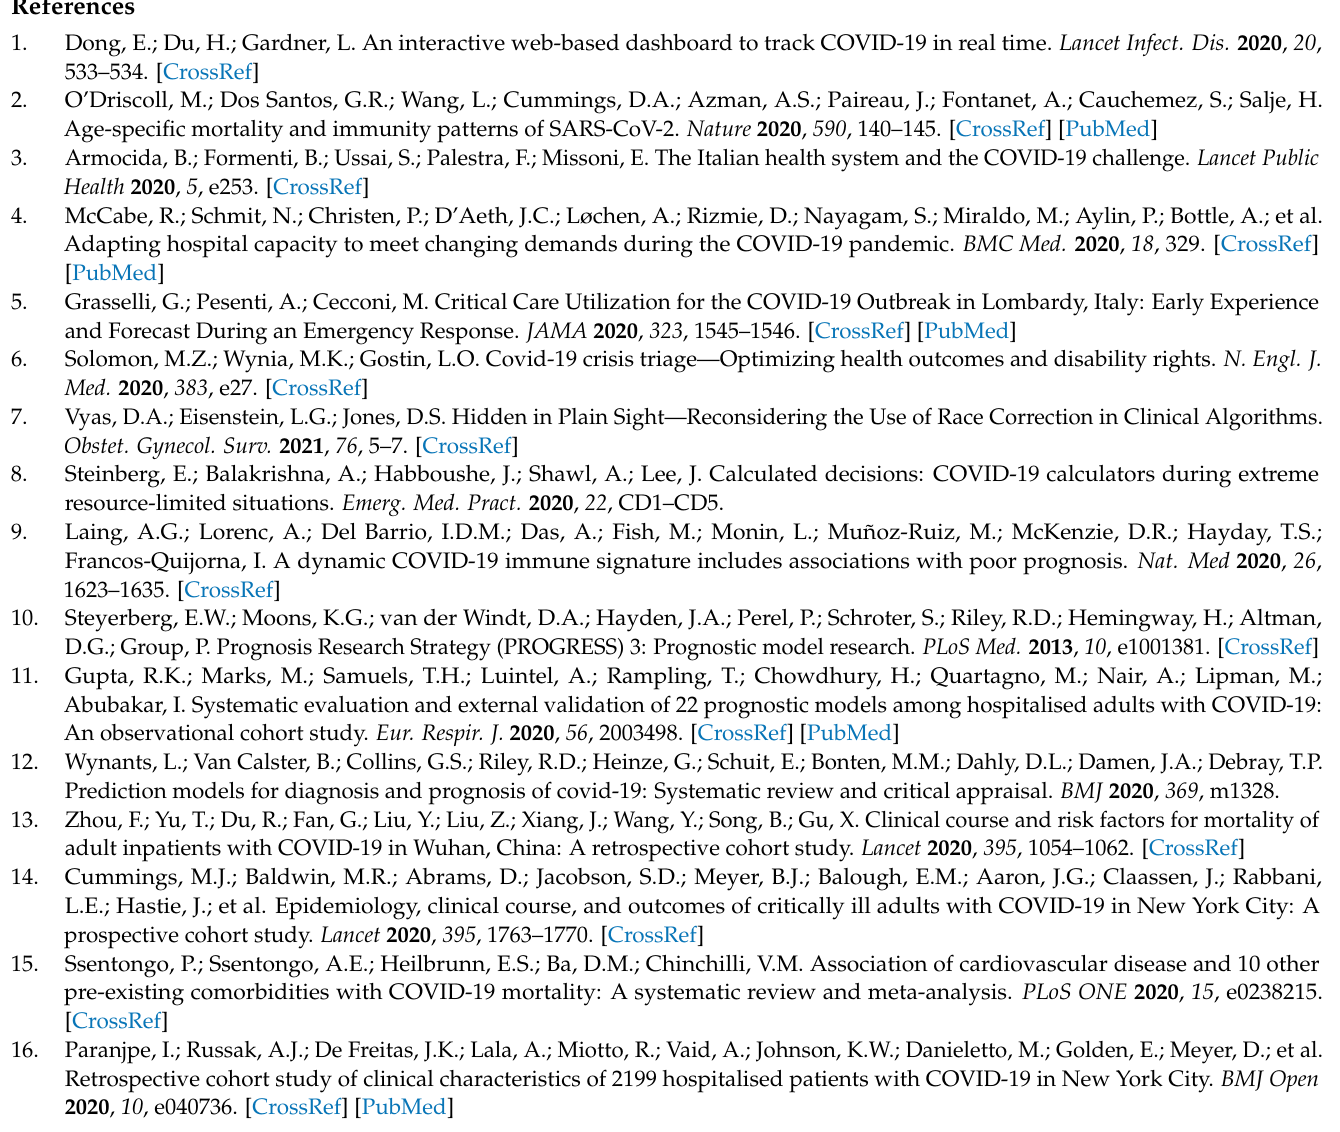
Table S6: Summary statistics of lab values, Table S7: Priors for Markov model parameters,